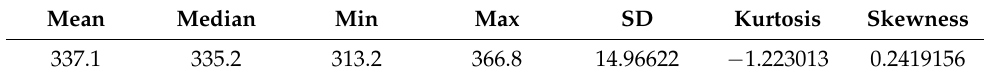
Table 3. Statistical characteristics of the “CO 2 ” dataset.